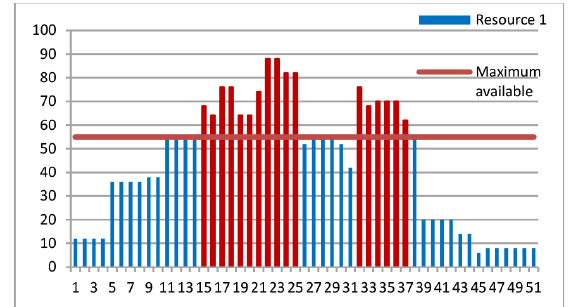
Figure 46. Daily usage of resource 1 throughout the calendar of the project (before using the method)-Experiment 3